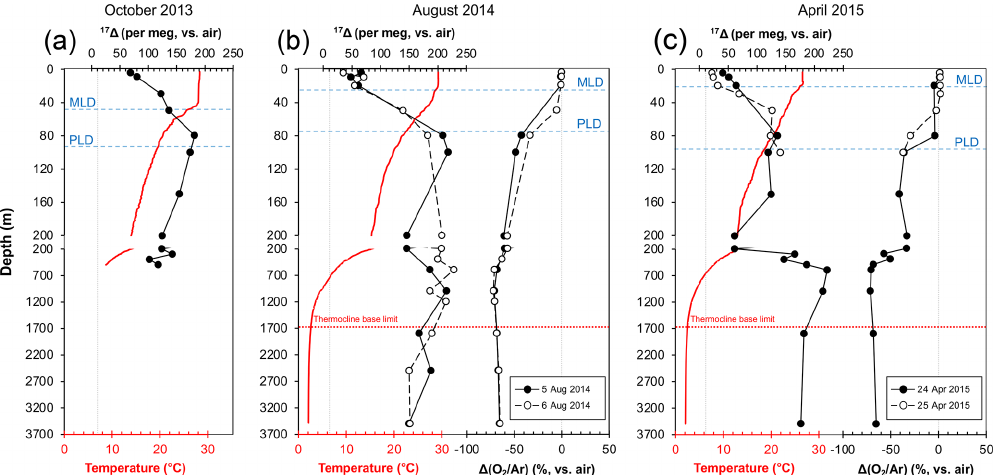
Figure 4. Depth profiles of temperature (red lines) and 17 (cid:49) and (cid:49) (O 2 / Ar) profiles (solid or dashed black lines) from SEATS from (a) 16 Oc- tober 2013 (inter-monsoon season), (b) 5–6 August 2014 (summer southwest monsoon) and (c) 24–25 April 2015 (winter northeast mon- soon). Vertical dashed grey lines indicate the equilibrium 17 (cid:49) and (cid:49) (O 2 / Ar) values with atmosphere. MLD – mixed-layer depth, PLD – photic layer